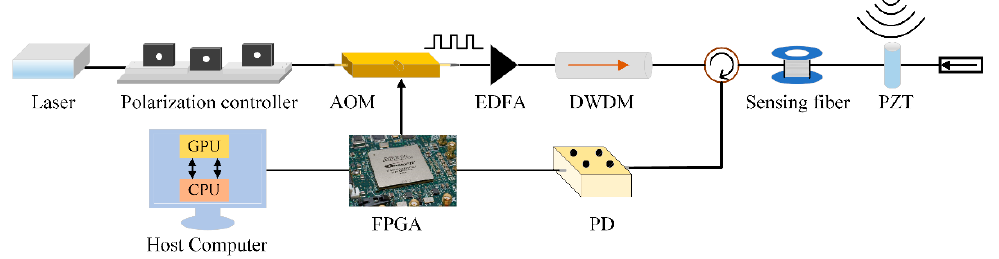
Figure 2. The diagram of experiment setup.